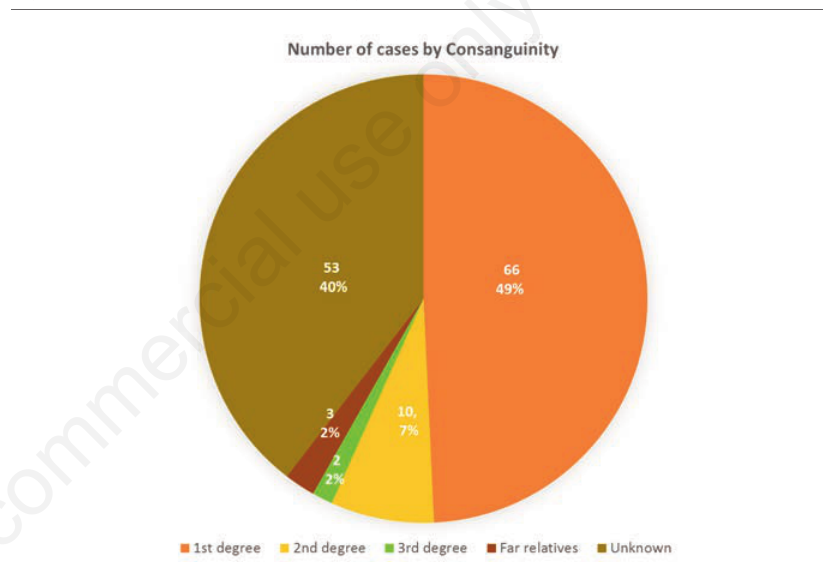
Figure 3. Number of cases by consanguinity.